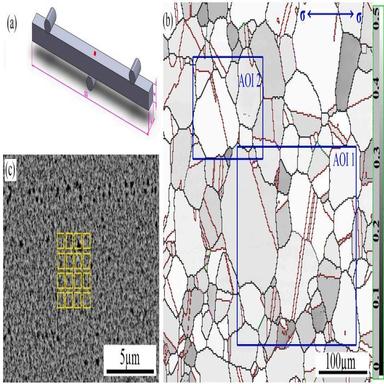
(a) Schematic diagram of the set-up of the three-point bending fatigue test; (b) Schmid factor map for the top central surface (as indicated by the red square shown in (a)), which contains two AOI for SEM-DIC study of strain localisation; (c) morphology of speckle pattern after pre-oxidation exposure. The yellow squares show the size of the subsets (i.e. 21pixels × 21 pixels or 0.656 μm × 0.656 μm) used for DIC analysis. (For interpretation of the references to colour in this figure legend, the reader is re